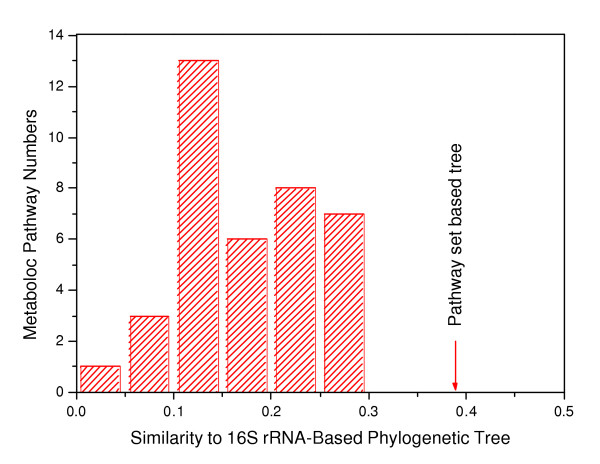
The distribution of similarity values betweensingle pathway-based trees and 16S rRNA-based trees. Thirty-seven pathways were studied. The similarity value between the pathway set based tree and the corresponding16S rRNA-based tree is indicated by an arrow.